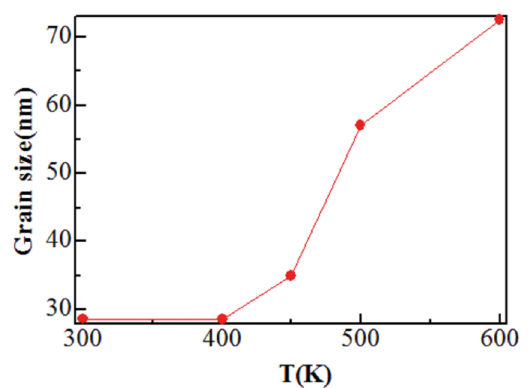
Figure 3. Change in the grain size of n -Ag by annealing at elevated temperatures for 30 of n -Ag is 37K